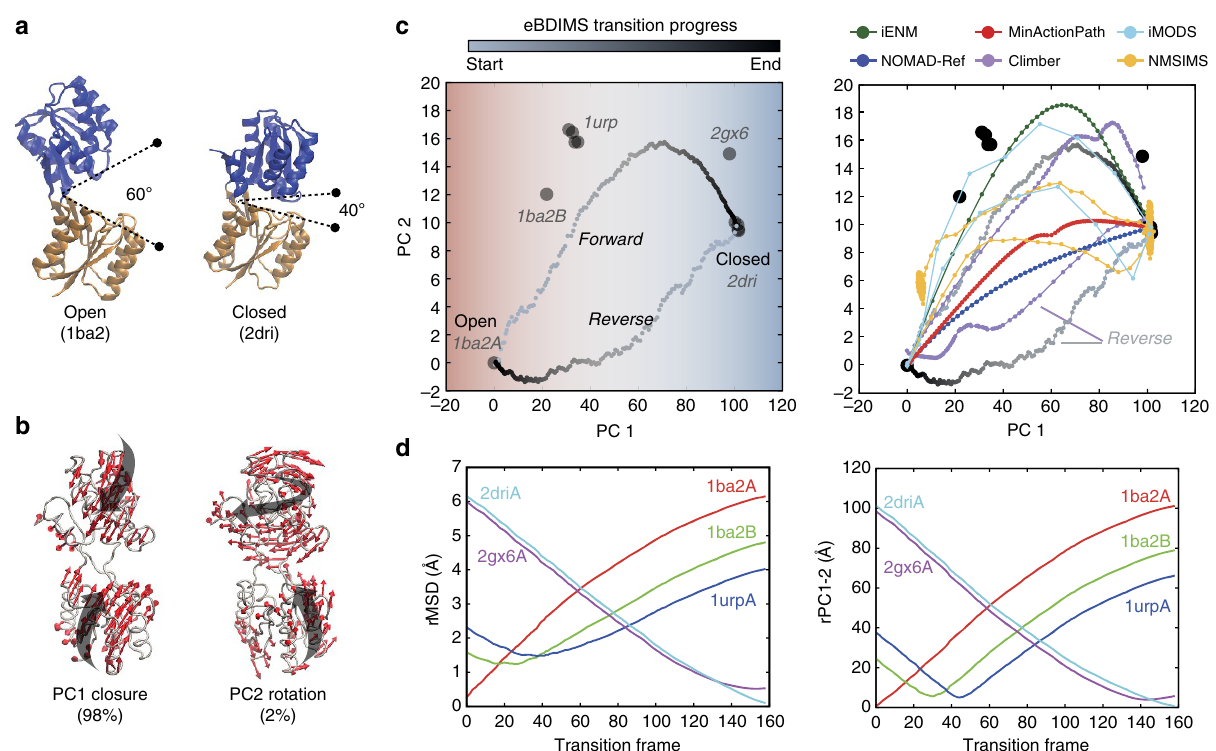
Figure 2 | Conformational transition of E. coli ribose-binding protein (RBP). ( a ) Crystallographic unbound (1ba2) and ribose-bound (2dri) state of RBP; the two ligand-binding domains are coloured in blue and orange. ( b ) Principal components of the X-ray ensemble (11 structures) track domain closing and subtle rotation versus the reference 1ba2. ( c ) Left: projection of the ensemble structures and the eBDIMS trajectories onto the PC1-2 subspace; note how PC1 separates the crystal structures into three–four clusters (shown as red (unbound), white (intermediates) and blue (bound) regions). Right: comparison between the forward pathways computed by eBDIMS, iENM, NOMAD-Ref, MinActionPath and Climber. Reverse pathways generated by eBDIMS, iMODS, NMSIM and Climber also shown. ( d ) rMSD and PC1-2 distance between the forward trajectory and the sequence of crystallographic